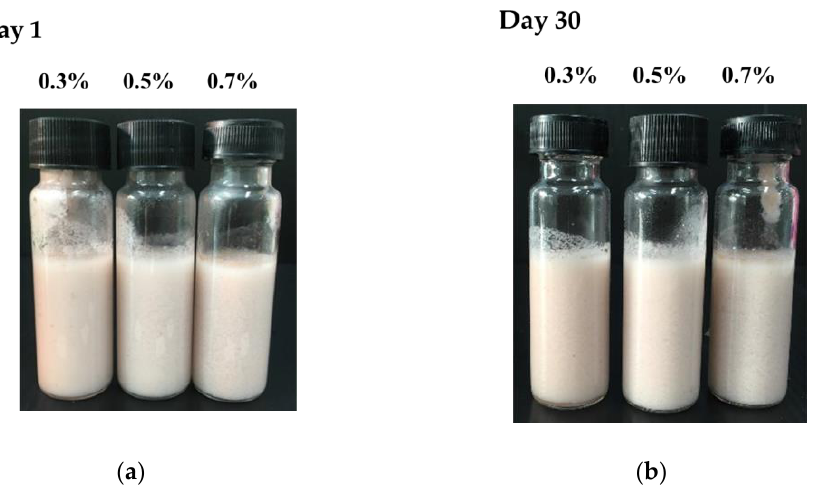
Figure 2. The appearance of the tested emulsions: ( a ) appearance of the freshly prepared AX-loaded emulsions; ( b ) AX-loaded emulsions after 30 days of storage. emulsions; ( b ) AX-loaded emulsions after 30 days of storage.